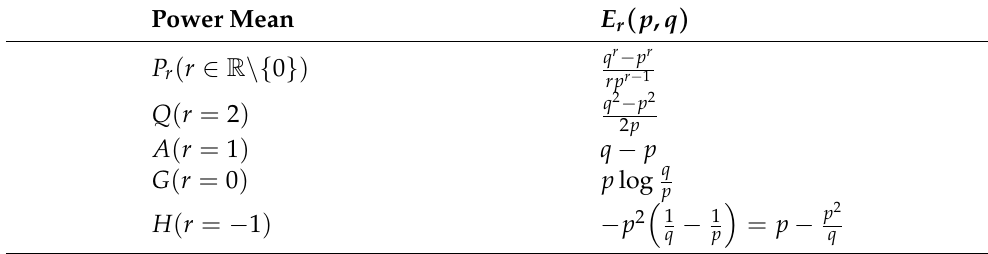
Table 1. Expressions of the terms E r for the family of power means P r , r ∈ R